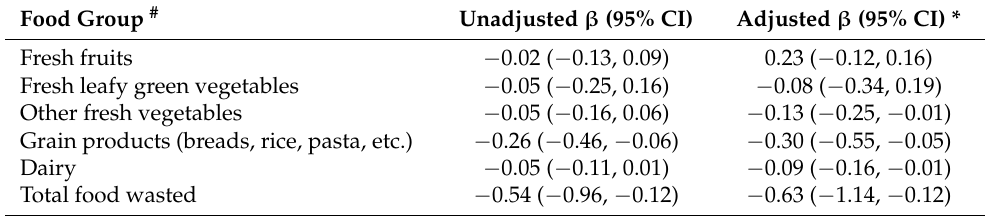
Table 4. Association between amount of food wasted and the diet quality of foods purchased (GPQI-2016 total